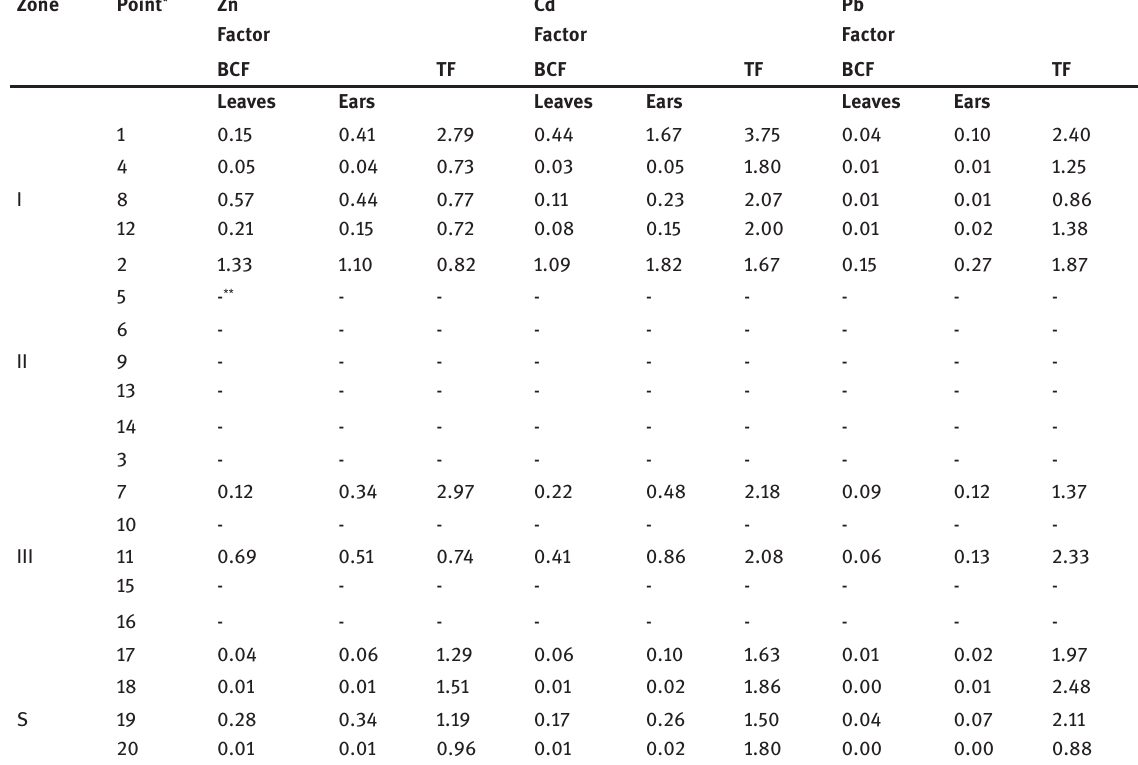
Table 2: Bioaccumulation (BCF) and translocation factors (TF). Zone Point